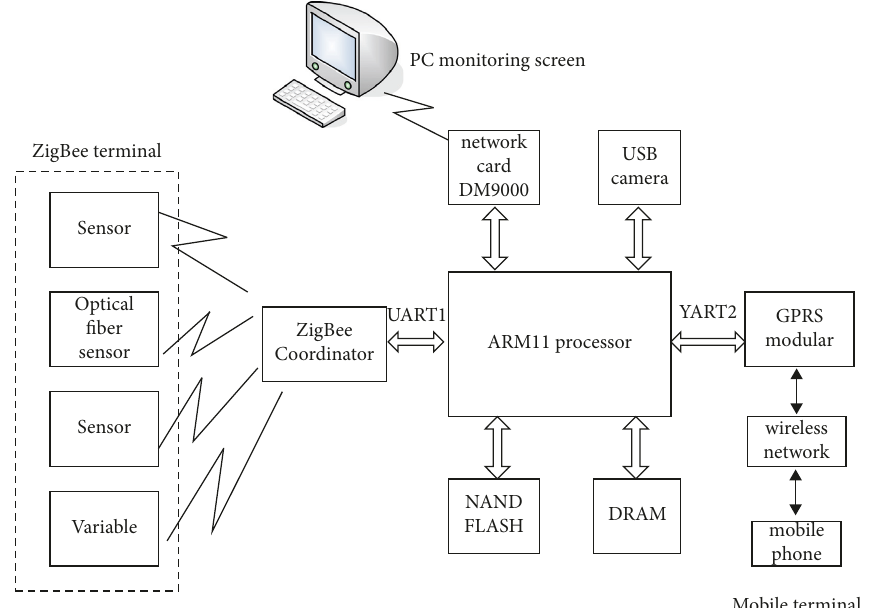
Figure 1: Structure diagram of remote monitoring system.